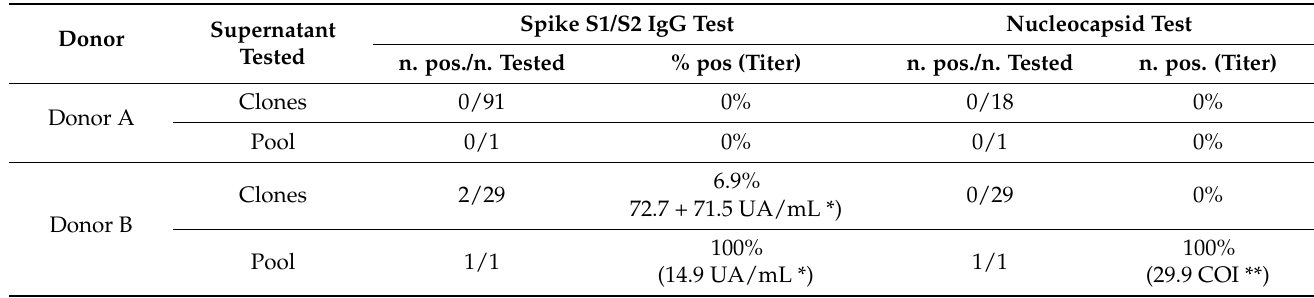
Table 1. Summary of antigenic tests results.